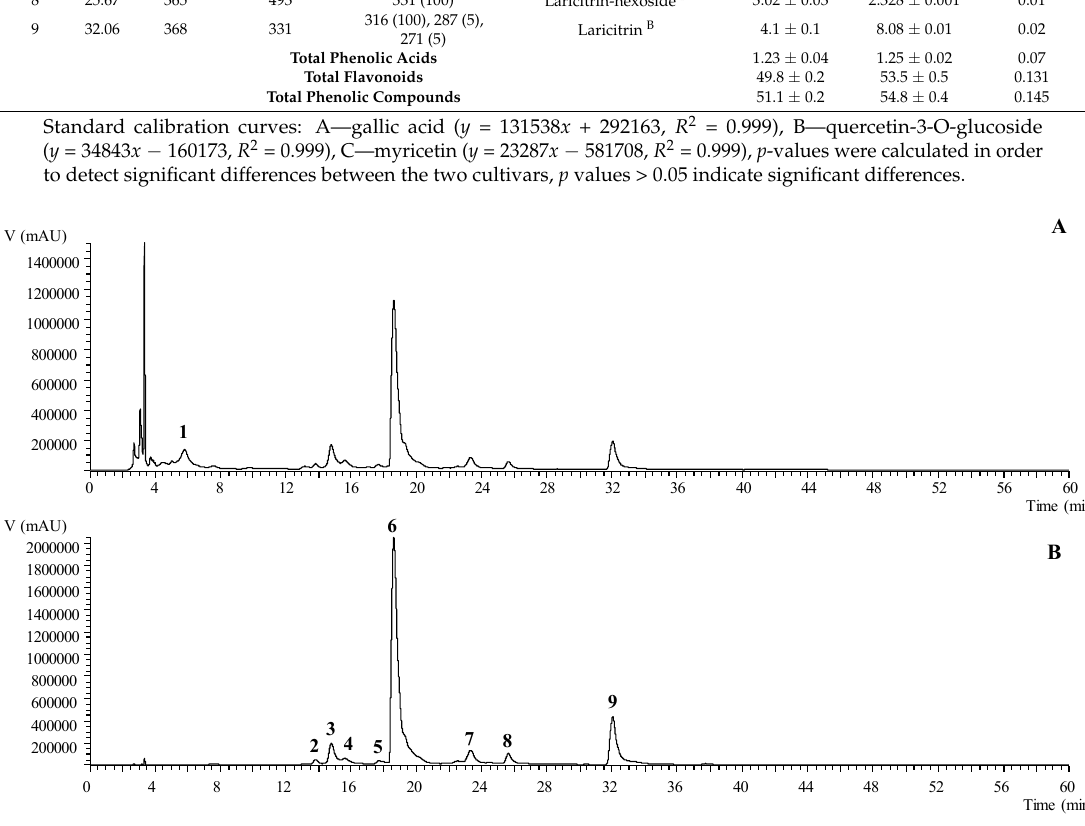
Figure 1. Phenolic profile of T. erecta yellow recorded at 280 nm ( A ) and 370 nm ( B ).